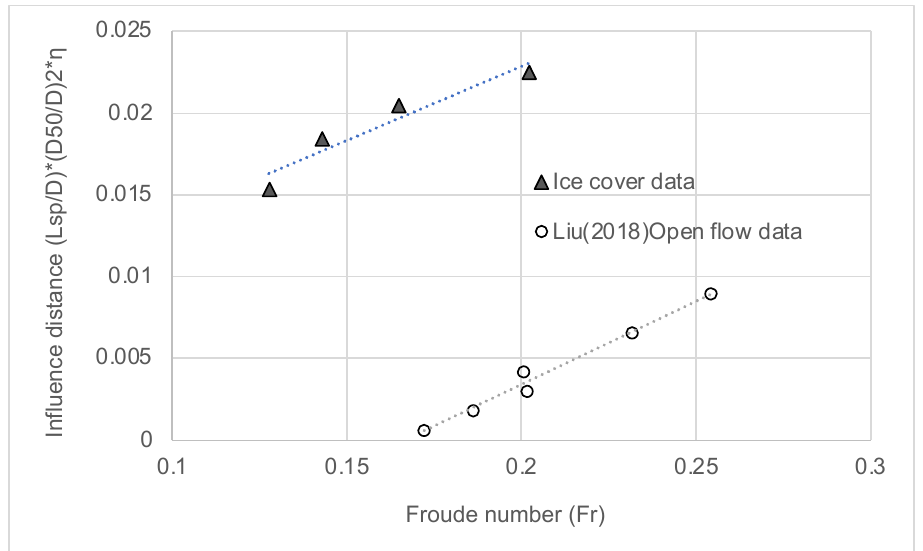
Figure 10. Relationship between the influence distance of the front pier on the rear pier and the flow Froude number.